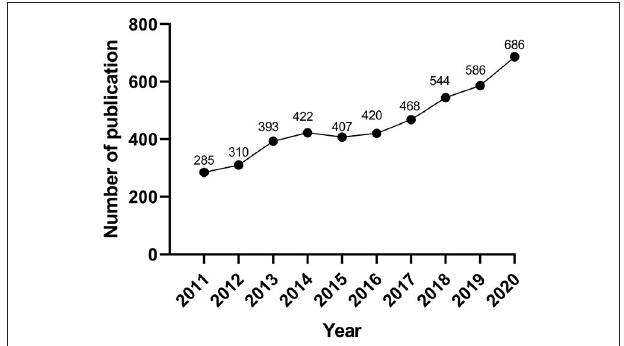
FIGURE 2 | The annual number of publications on pulmonary rehabilitation between 2011 and 2020.